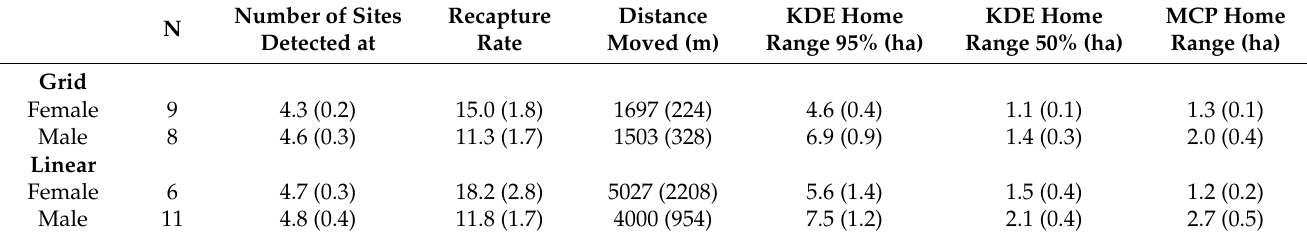
Table 4. Short term home ranges (50% and 95%) using Kernel Density Estimate (KDE), of sugar gliders ( Petaurus breviceps ) detected at four or more sites (n = 34). Recapture rates were calculated as the number of distinct nights and site, that an individual was observed at. Minimum convex polygon (MCP) home range estimates were calculated by masking available habitat. Standard Error is show in